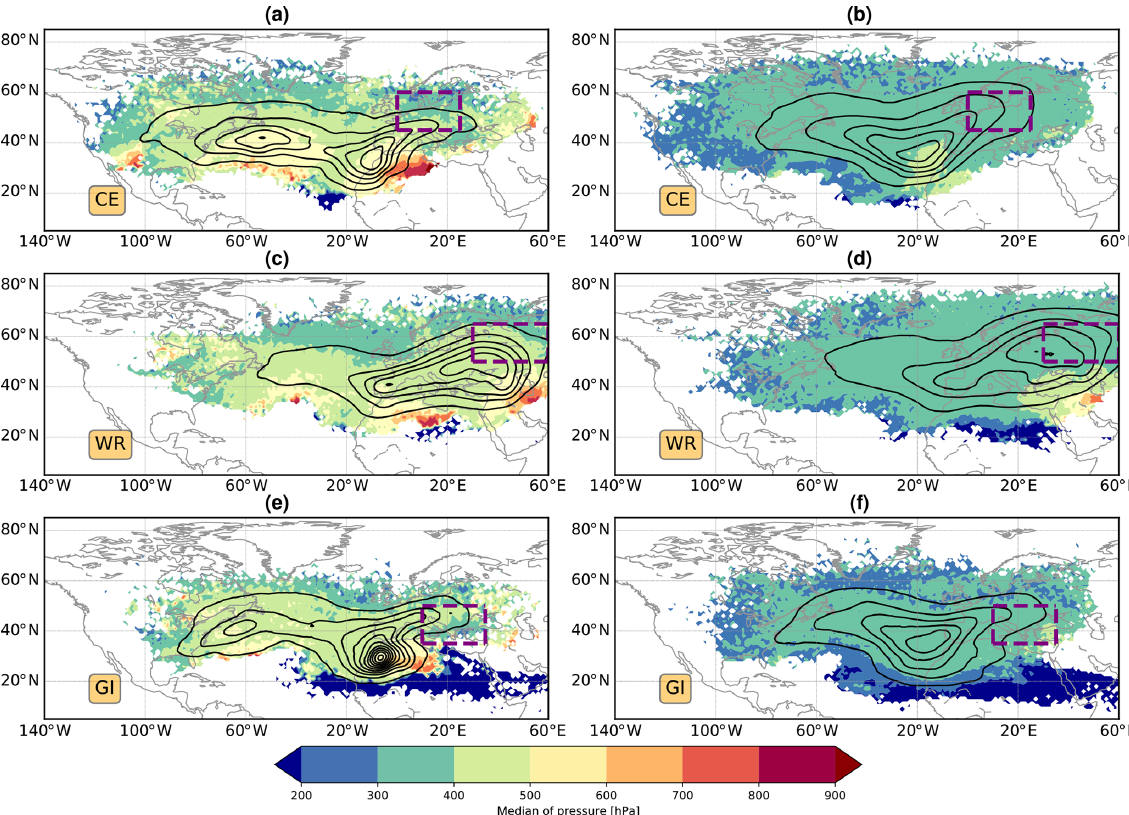
Figure 3. Spatial distribution of diabatically heated (a, c, e) and cooled (b, d, f) trajectories 3d prior to arrival in the upper-tropospheric anticyclones for (a, b) central Europe (CE), (c, d) western Russia (WR) and (e, f) Greece–Italy (GI). The colours indicate the median pressure of air parcels, and contours display the air parcel density (starting from 1‰ per 10 5 km 2 in 2‰ increments). The dashed purple boxes represent the area in which upper-tropospheric anticyclones are associated with heat waves (see Sect. 2.1 and Fig.